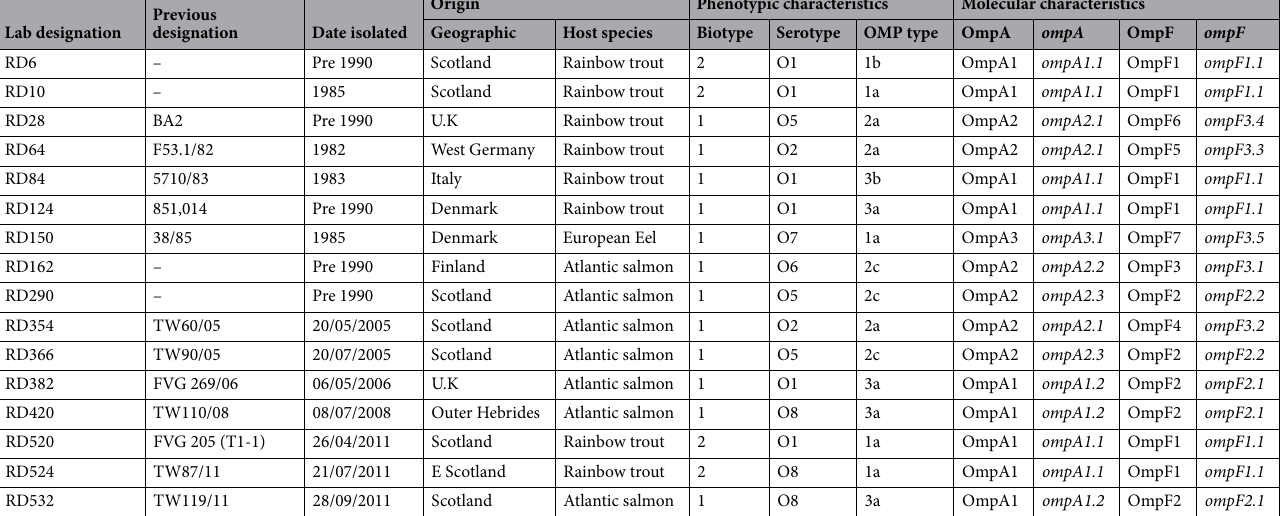
Table 1. Properties of Yersinia ruckeri isolates included in the sequencing study.